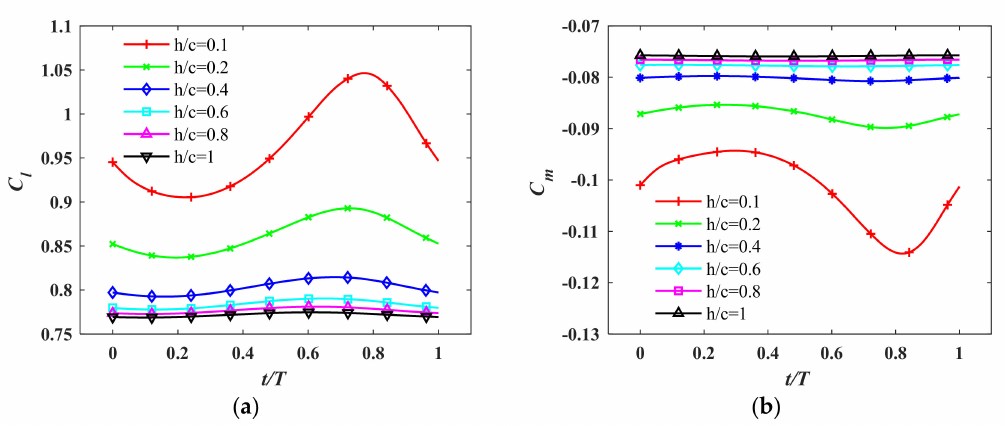
Figure 13. The change in the aerodynamics of di ff erent ride heights at α = 4 ◦ : ( a ) lift coe ffi cient, ( b ) moment coe ffi cient.